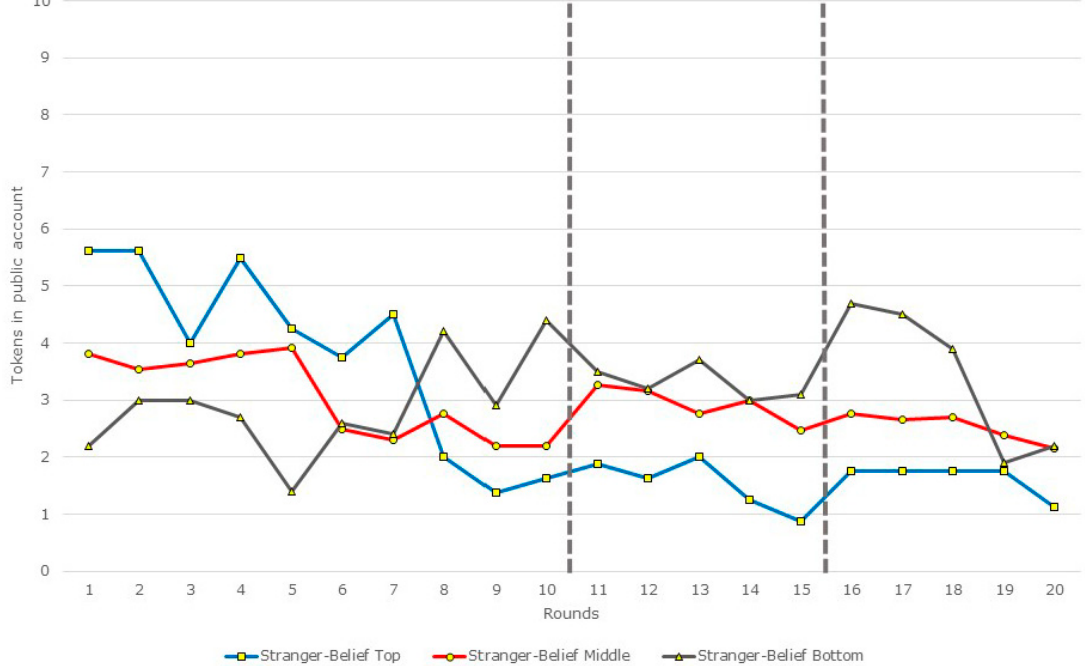
Figure 2. Overview of contributions by the three different types with stranger matching.